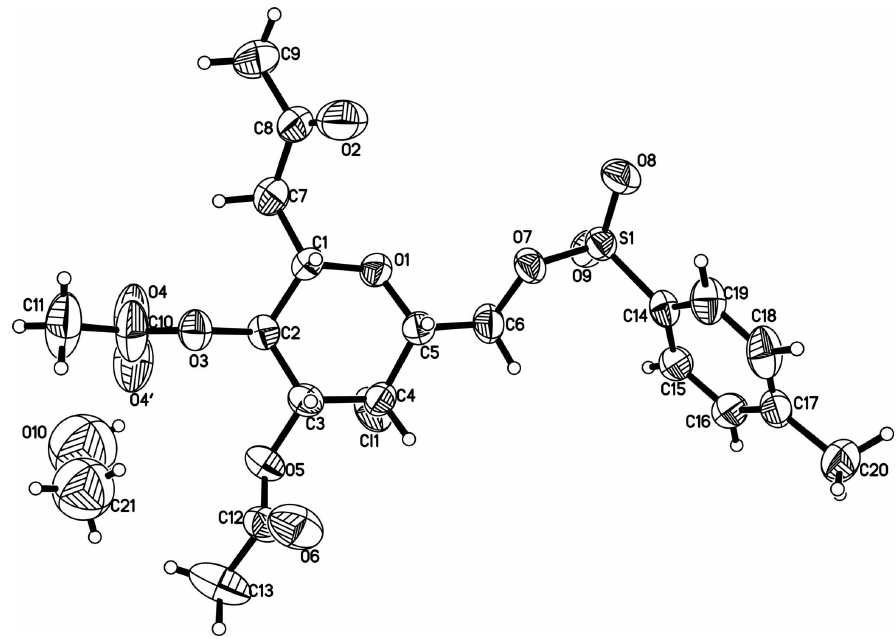
Figure 1 The molecular structure of (I), showing atom displacement ellipsoids drawn at the 50% probability level. 1-(2,3-Di- O -acetyl-4-chloro-4-deoxy-6- O -tosyl- β -D- galactopyranosyl)propan-2-one methanol